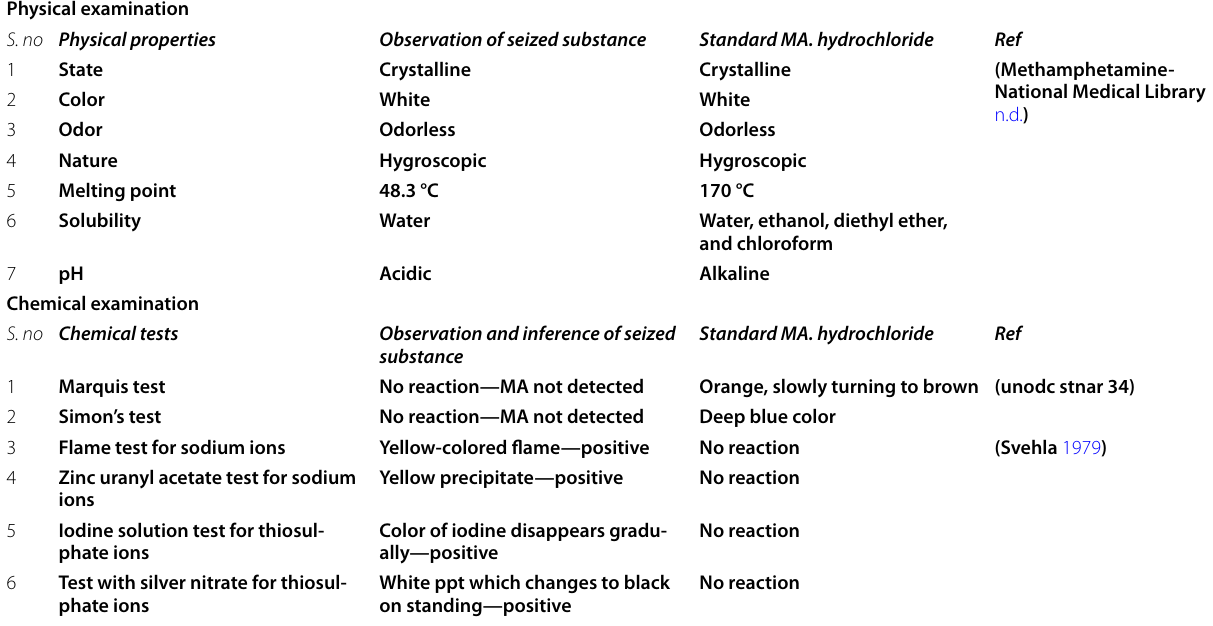
Table 1 The chemical and physical tests